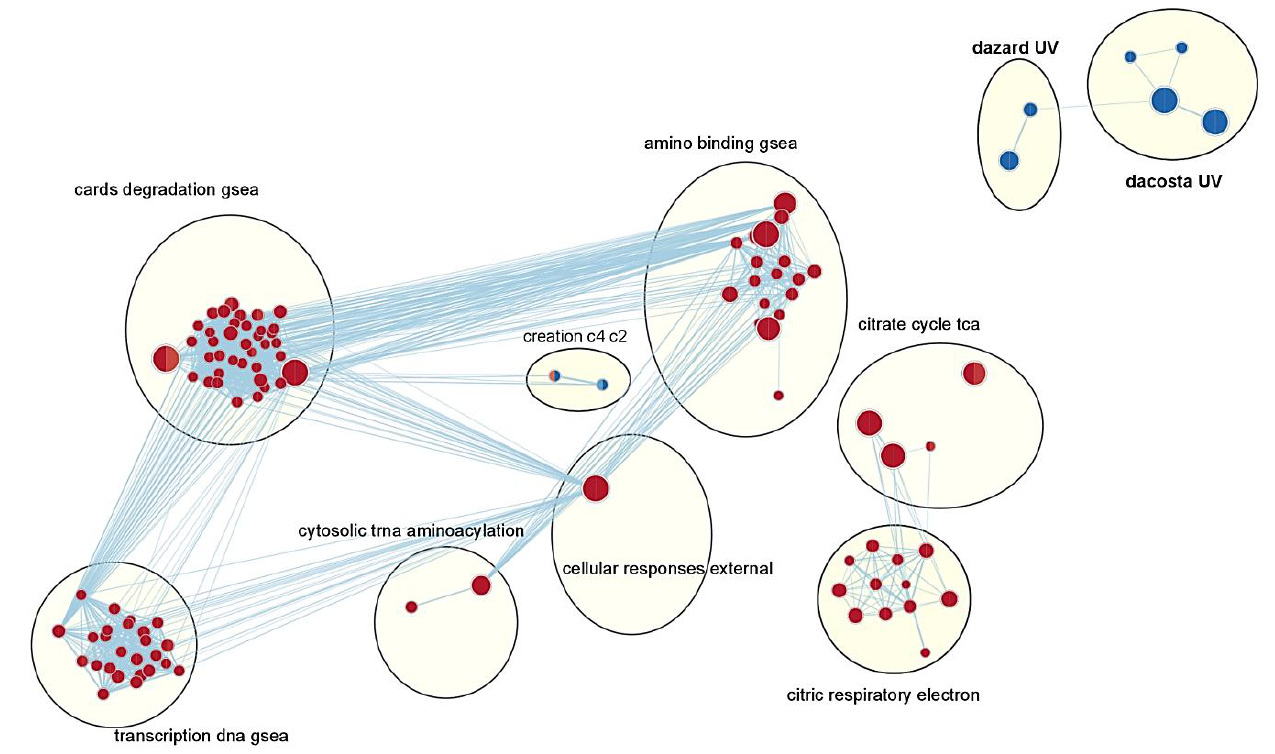
Figure 2. Network analysis of gene set enrichment. Each node represents one gene set. The left half of the circle represents the correlation after 6 h of NaCl treatment, and the right half of the circle represents the correlation after 12 h of NaCl treatment (each n = 3). The size of the nodes represents the number of genes in the node; edges represent the correlation of the nodes; p = 0.05, red = positively correlated gene sets, blue = negatively correlated gene sets, bold: gene sets of interest; nodes with no edges to other gene sets are not shown.